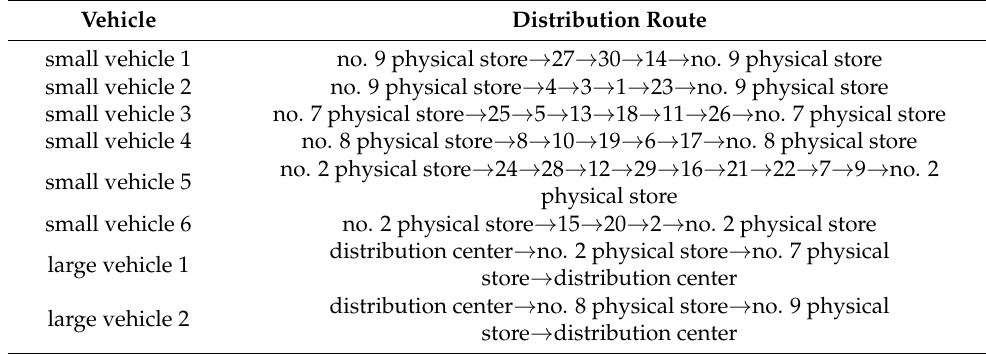
Table 7. Optimization scheme of vehicle distribution route. Vehicle